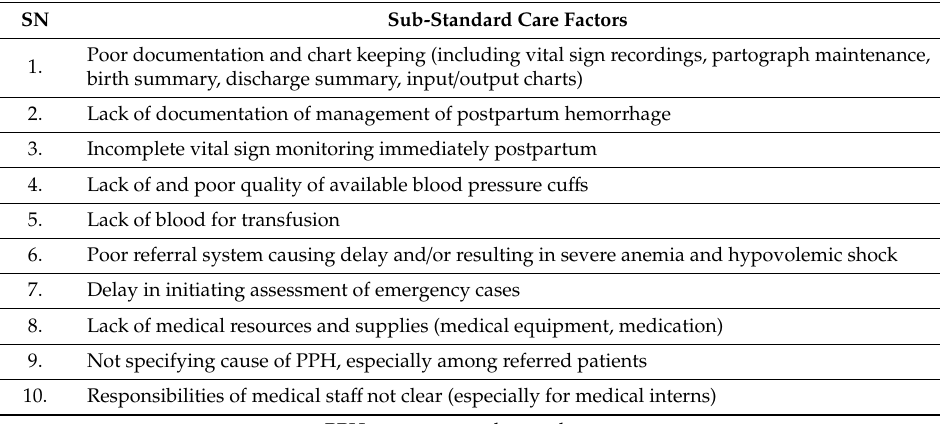
Table 3. Substandard care factors in management of PPH in HFSUH, eastern Ethiopia, 2019. SN